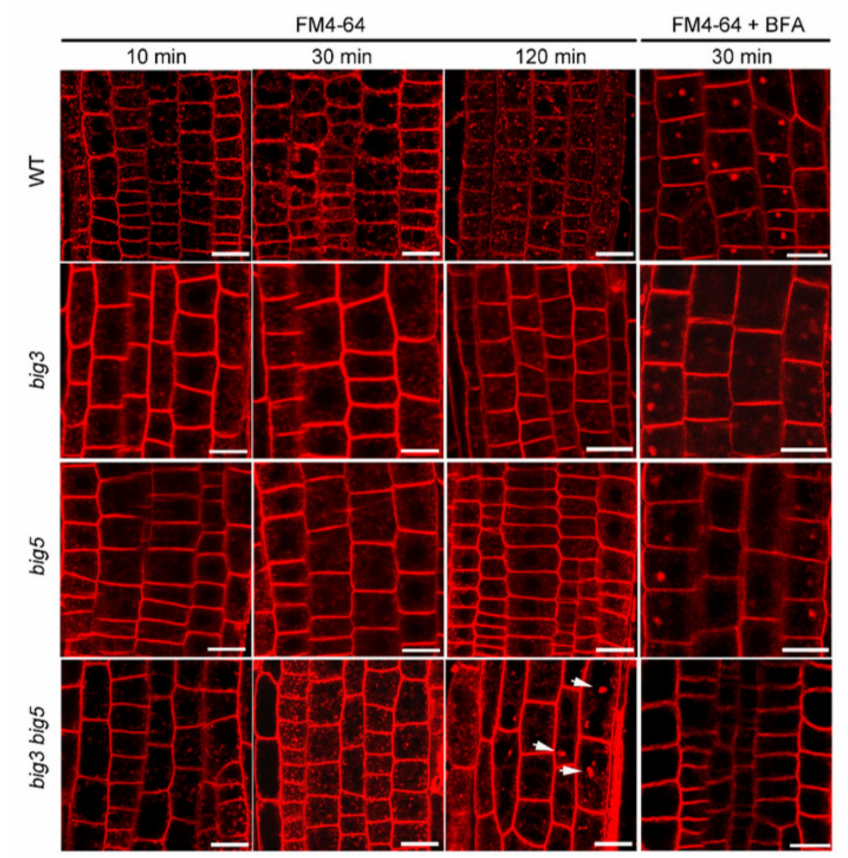
Figure 4. BIG3 and BIG5 are functionally redundant in vesicle formation from the plasm membrane. Confocal microscopy analysis of FM4-64 uptake and vesicle trafficking in roots of 7-d-old WT, big3 , big5 and big3 big5 . Seedlings were treated with 10 µ M FM4-64 for 10, 30 and 120 min, or with 10 µ M FM4-64 and 25 µ M BFA simultaneously for 30 min. Arrowhead indicate the bigger vesicles such as BFA bodies in big3 big5 cells 120 min after FM4-64 treatment. Bars = 15 µ